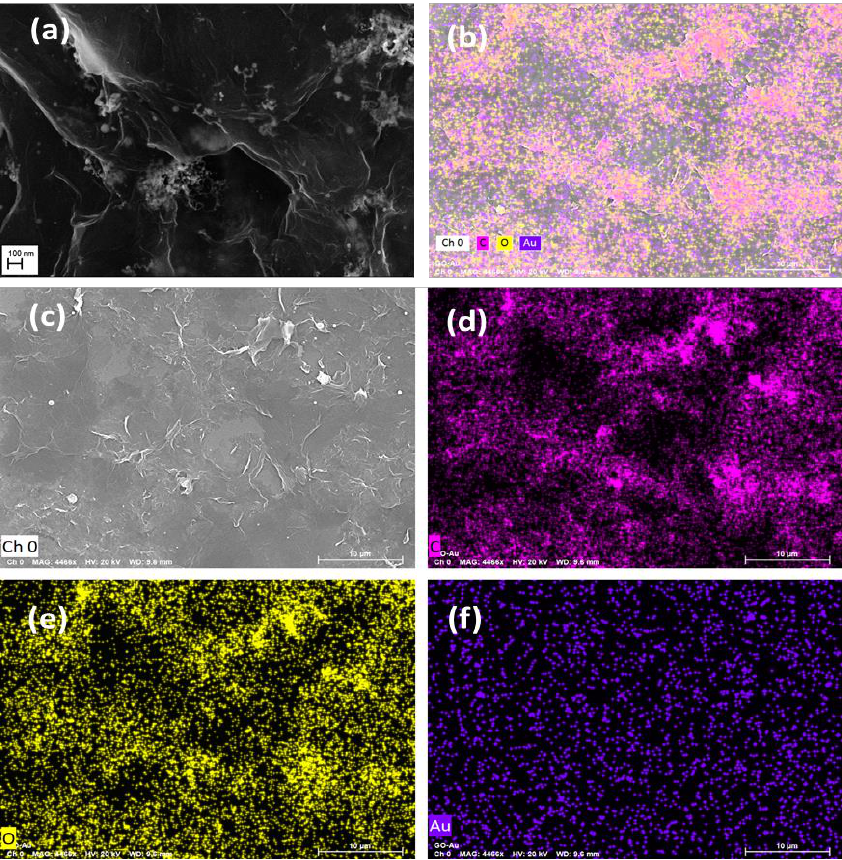
Figure 6. ( a ) Field emission (FESEM) image of the Au-GO nano-hybrid ( b – f ) elemental mapping of Au-GO nano-hybrid, where C, O and Au are mapped in pink, yellow and blue colours respectively